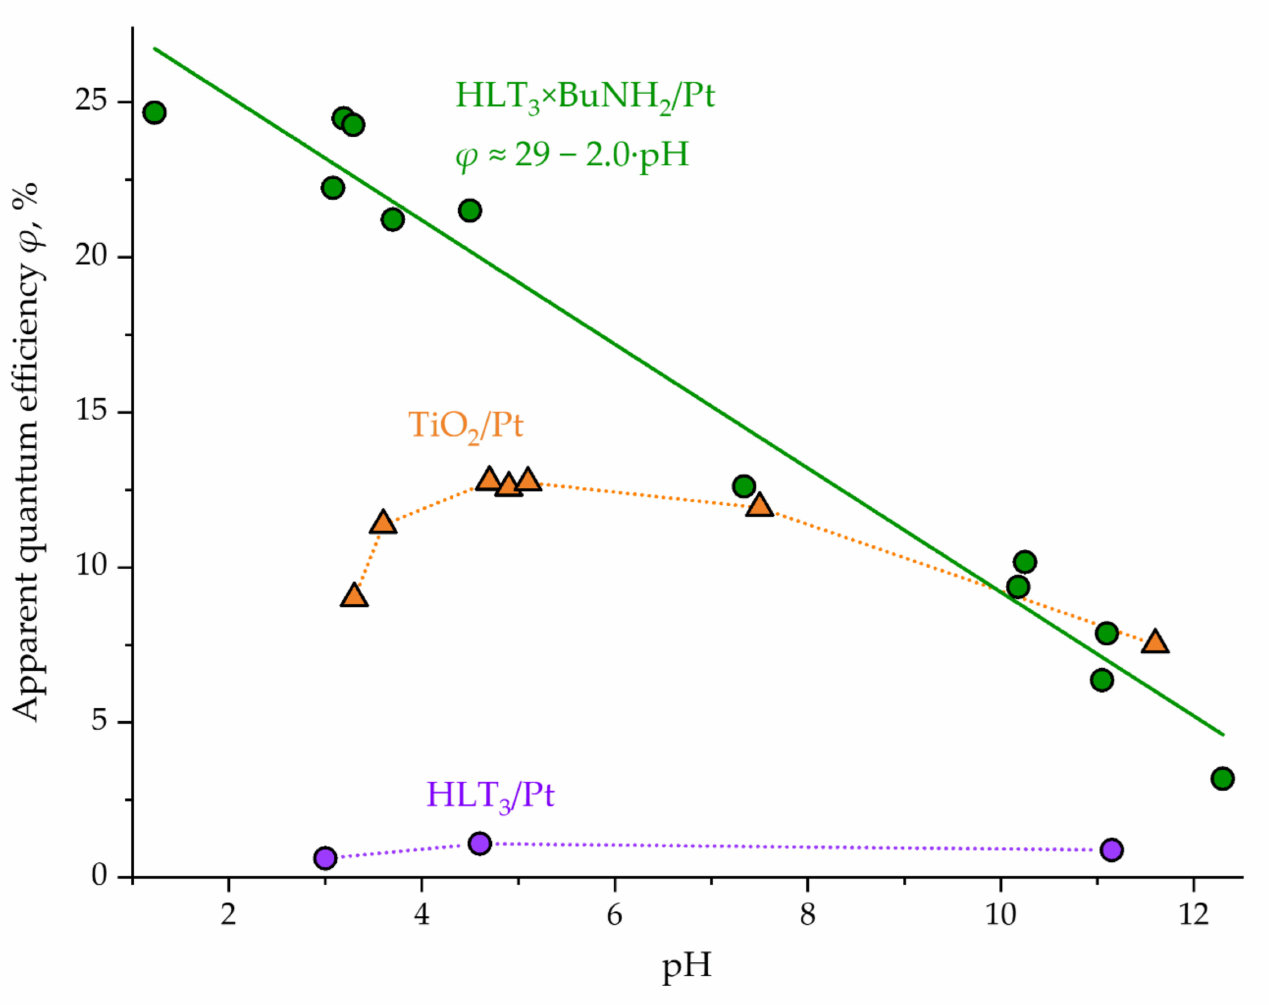
Figure 7. Dependence of apparent quantum efficiency of hydrogen evolution from 1 mol.% aqueous methanol on the solution pH for the platinized titanate HLT 3 /Pt, its n -butylamine-intercalated form HLT 3 × BuNH 2 /Pt and platinized TiO 2 P25 for